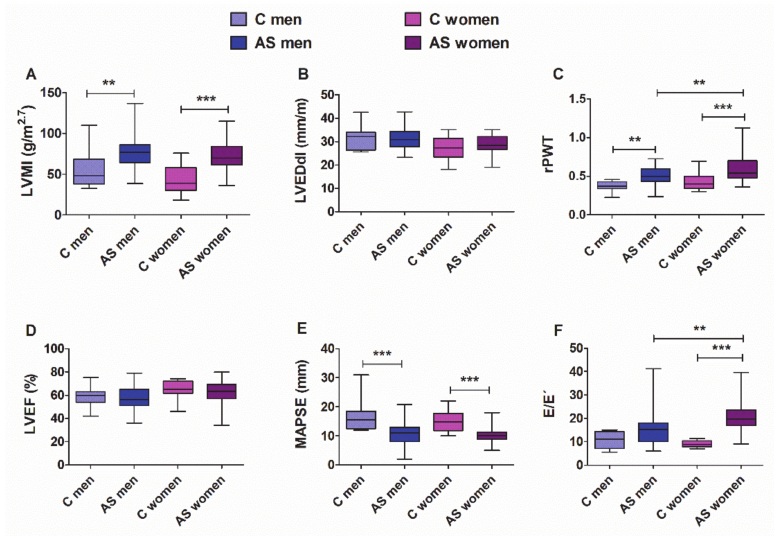
Figure 7. Morphological and functional echocardiographic parameters in controls and men and women with AS who were older than 50 years of age. ( A ) LVMI, LV mass index; ( B ) LVEDdI, LV end-diastolic diameter index; ( C ) rPWT, relative posterior wall thickness; ( D ) LVEF, LV ejection fraction; ( E ) MAPSE, mitral annular plane systolic excursion; ( F ) E / e (cid:48) , the ratio of peak early transmitral flow velocity to peak early myocardial tissue velocity (e (cid:48) ). Whiskers represent the 10th–90th percentiles. ** p < 0.01, *** p < 0.001 (two-way ANOVA followed by Bonferroni post hoc test). Control patients: men = 11, women = 15; AS patients: men = 45, women = 50. For MAPSE, control: men = 8, women = 10; AS patients: men = 42, women = 45. For E / e (cid:48) , control: men = 5, women = 5; AS patients: men = 24 and women =